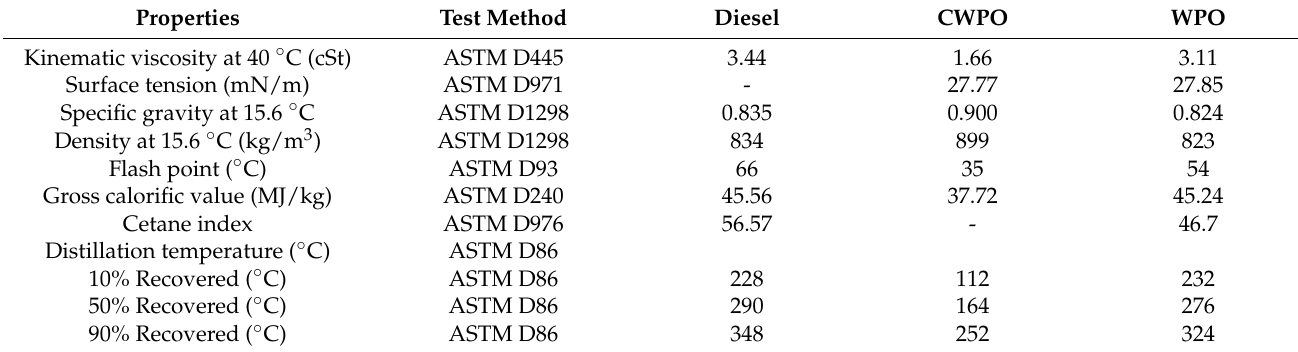
Table 5. Basic physicochemical properties of CWPO, WPO, and diesel fuel.